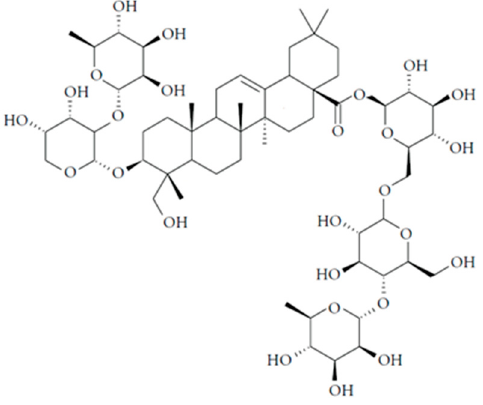
Figure 1. Structure formula of hederacoside C.